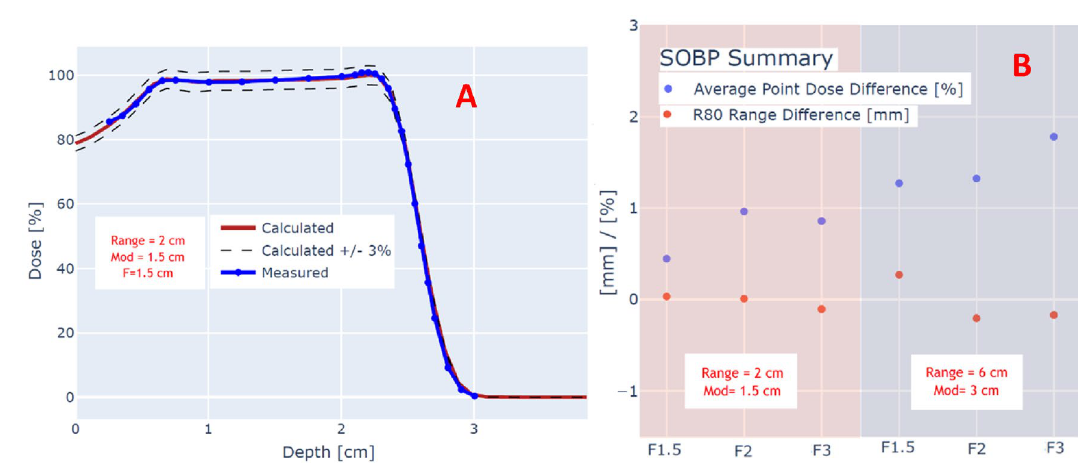
Figure 3. ( A ) Depth dose comparison between measured and calculated SOBP with a range of 2 cm, modulation of 1.5 cm, and circular field size of 1.5 cm. The ± 3% error bars are shown as dotted lines along with the depth dose. ( B ) Average point dose and R80 range differences for SOBP beams as a function of circular field Figure 5B shows the point dose comparisons for measurements around the center of modulation for SOBP beams with varying field sizes. Like Bragg peaks, no discrepancy between calculated and measured point doses